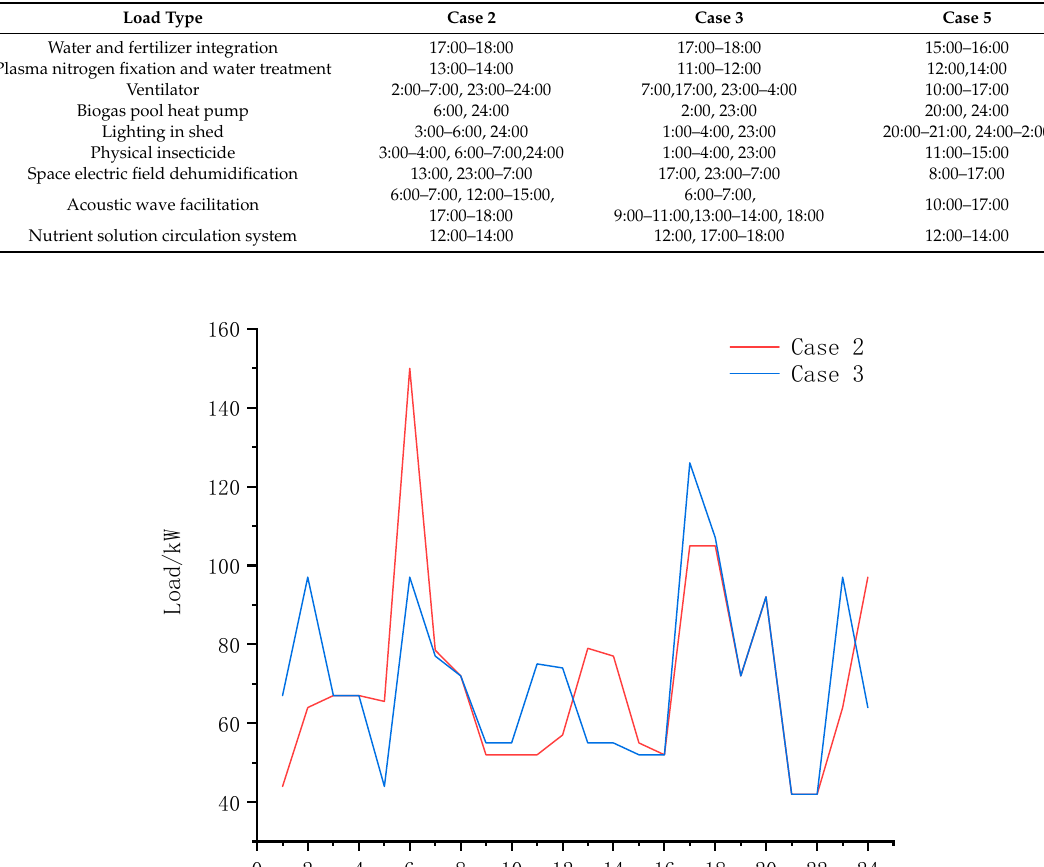
Table 15. The electricity purchasing and selling status, PV absorption status and synthetic operation cost in five cases.